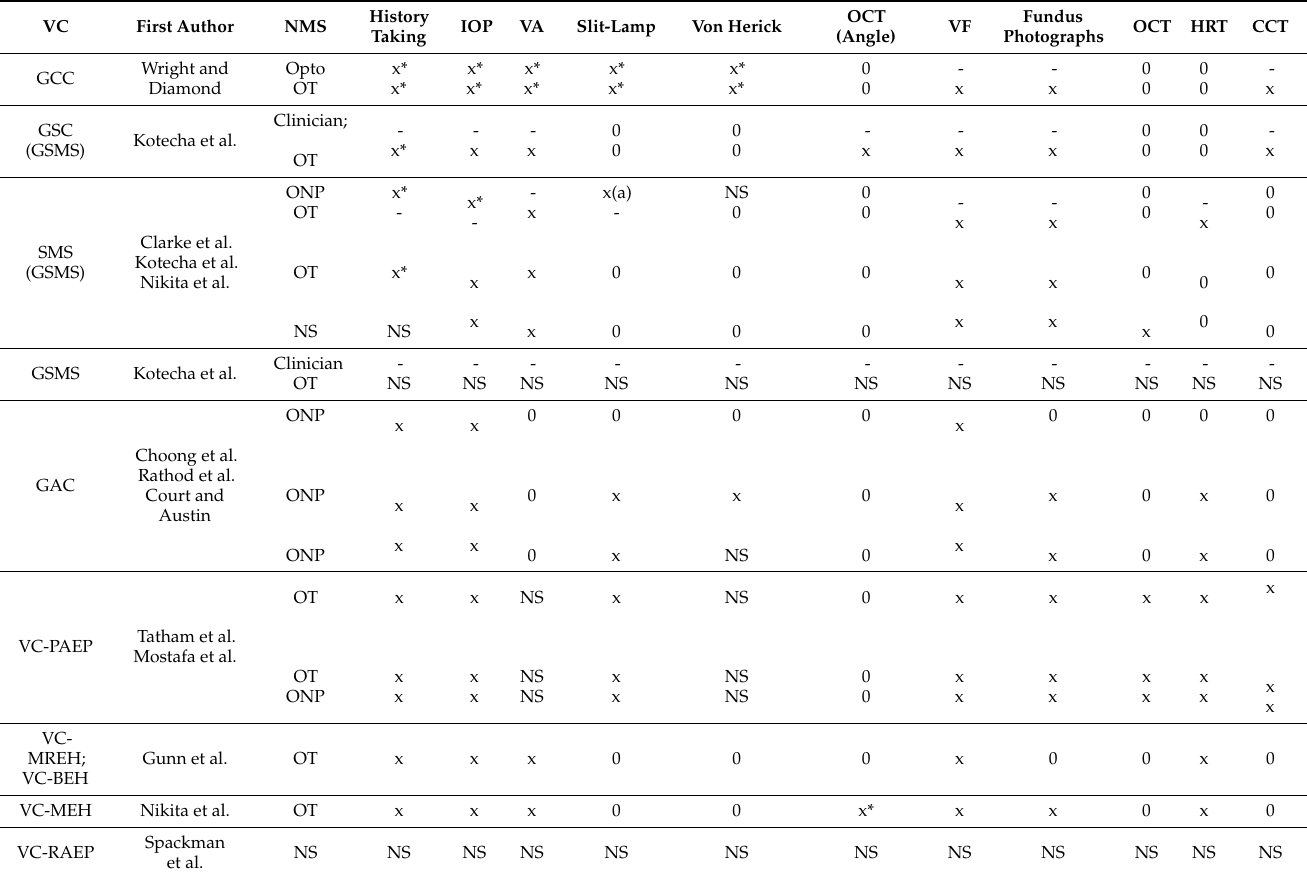
Table 6. The prerequisite skills of the non-medical staff working in the corresponding virtual